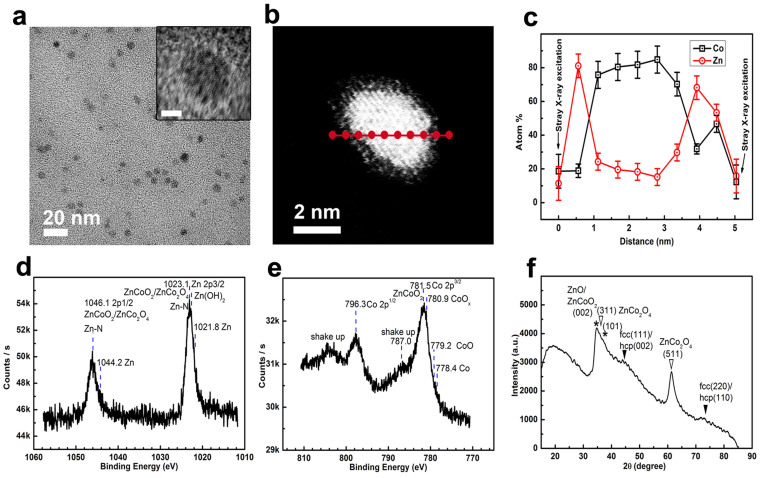
Wide-viewed TEM image (a), HR-TEM image of one single particle (a: inset, scale bar: 2 nm), STEM-HAADF image of one single particle (b), point-by-point EDX scanning of one single particle (c), high energy resolution XPS for Zn (d), high energy resolution XPS for Co (e) and XRD (f) of CoZn@Zn(1-x)CoxOy nanohybrids synthesized using aqueous-phased metal salt reaction systems.JCPDS No for XRD analysis: fcc Co, 15-0806; hcp Co, 05-0727; wurtzite ZnO, 36-1451; spinel ZnCo2O4, 23-1390. In XRD (vi), : the corresponding metallic phases;  and *: the corresponding metal oxides.